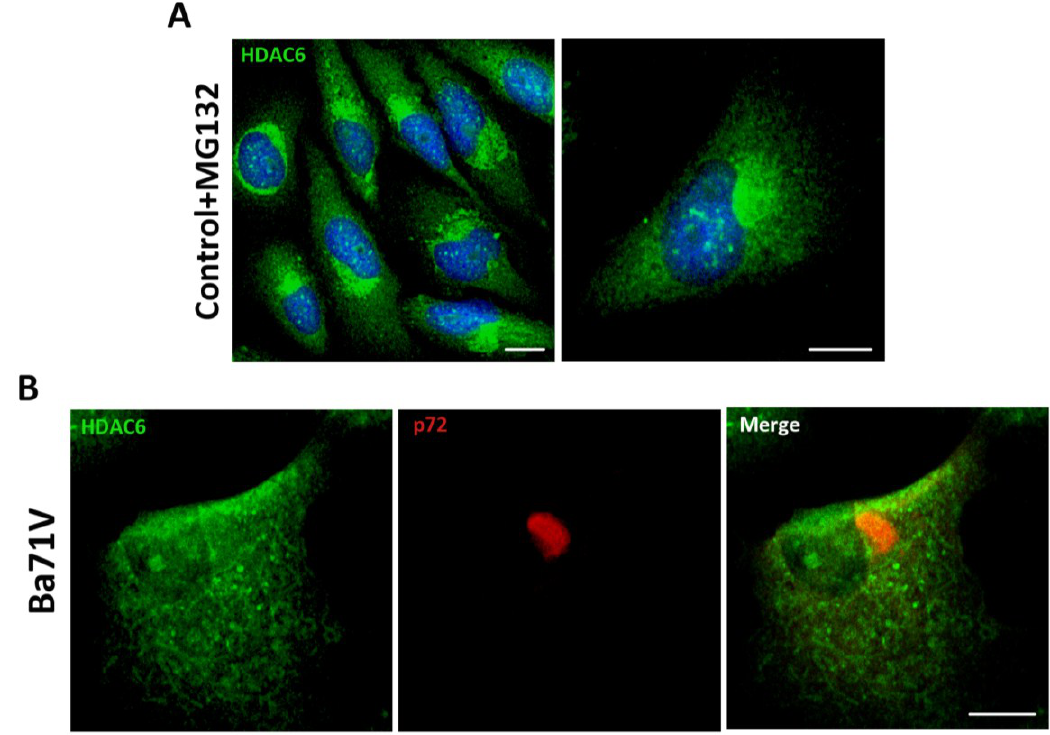
Figure 1. Analysis of histone deacetylase 6 (HDAC6) colocalization with African swine fever virus (ASFV) viral factories (VFs). ( A ) Analysis of HDAC6 expression in Vero cells treated with proteasome inhibitor MG132 (5 mM) for 16 h; ( B ) Cellular localization of p72 viral protein (red) and HDAC6 (green) in ASFV-infected Vero cells (moi = 5 pfu/cell) at 16 hpi. Bar = 10